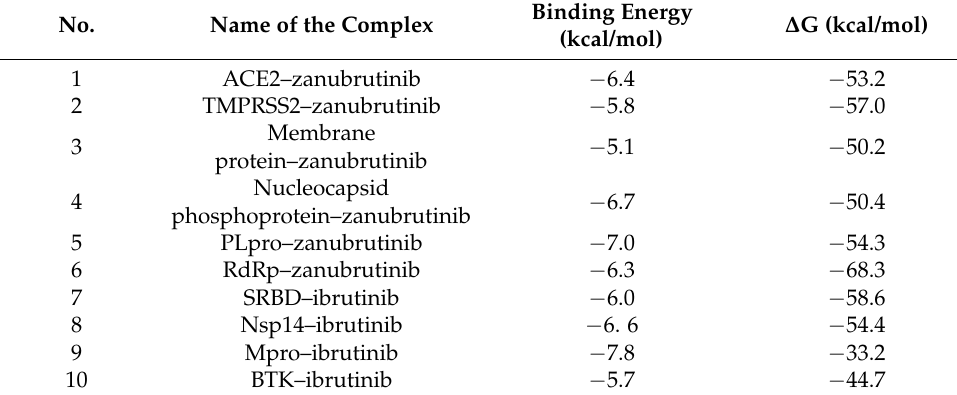
Table 5. Docking score (binding energy) and binding free energy of the selected target zanubrutinib and ibrutinib